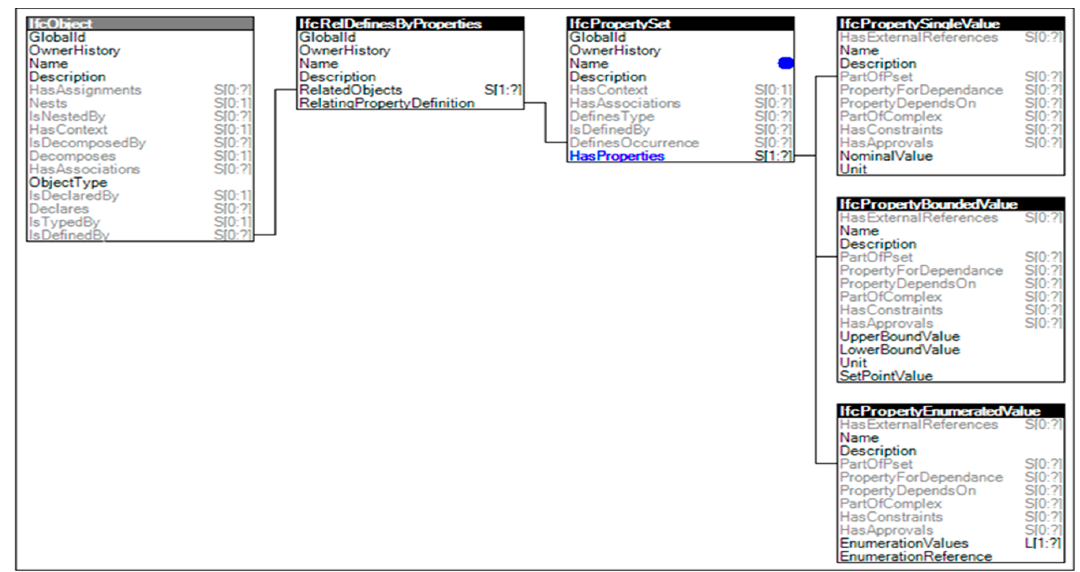
Figure 9. IFC support path.